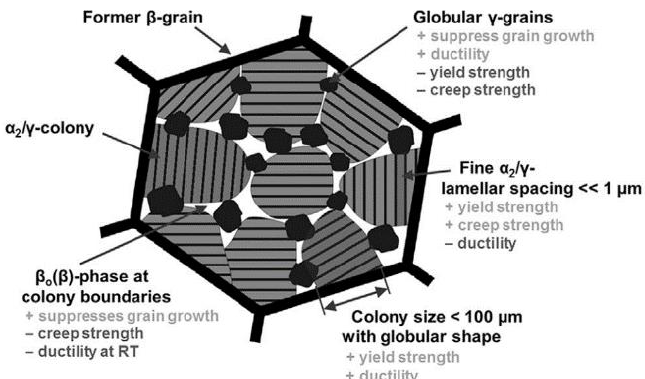
Figure 2. Influence of microstructural constituents on mechanical properties. Reprinted with permission from Ref. [13]. 2017, S. Mayer et al.